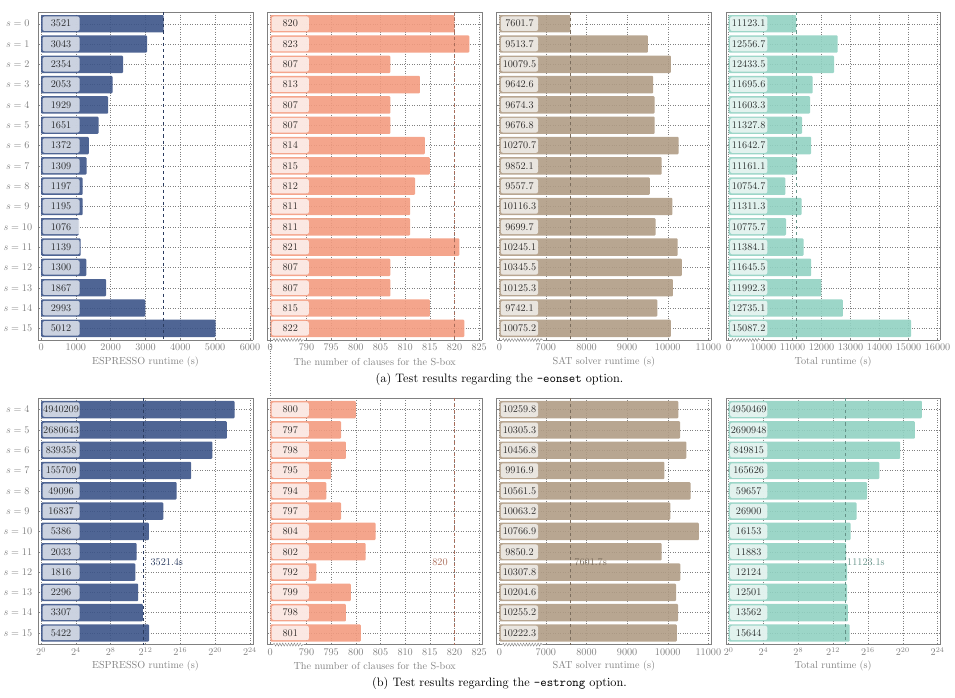
Figure 2: Iterative simplification for the 26-bit Boolean function f s = 0 indicates that the partitioning method is not employed. Total runtime is the sum of ESPRESSO and SAT solver execution times. Note that for s < 4, the simplification with the -estrong option does not return the result after more than sixty days, making it